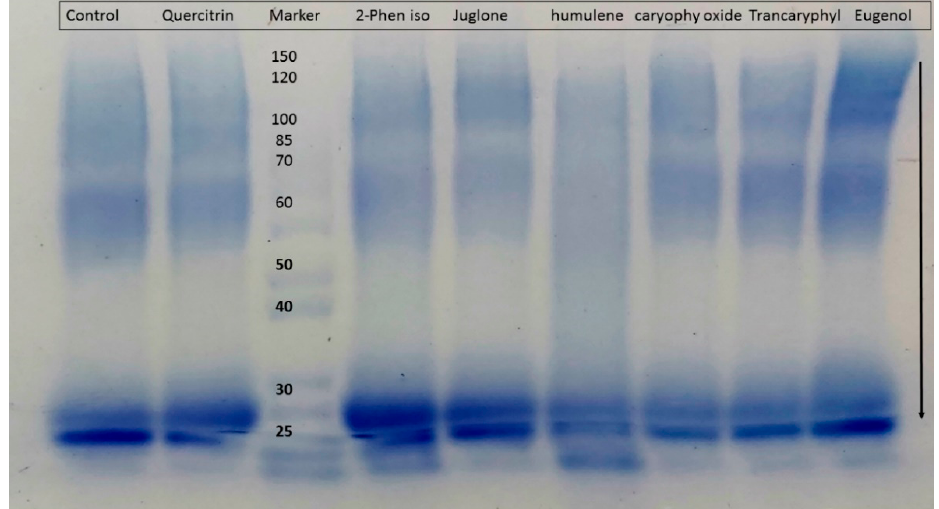
Figure 4. Gel showing BSA-MGO glycation with test compound (Control = BSA + MGO); Quercitrin = Quercitrin + MGO; Marker = Protein ladder; 2-Phen iso = 2-Phenylethylisothiocyanate +